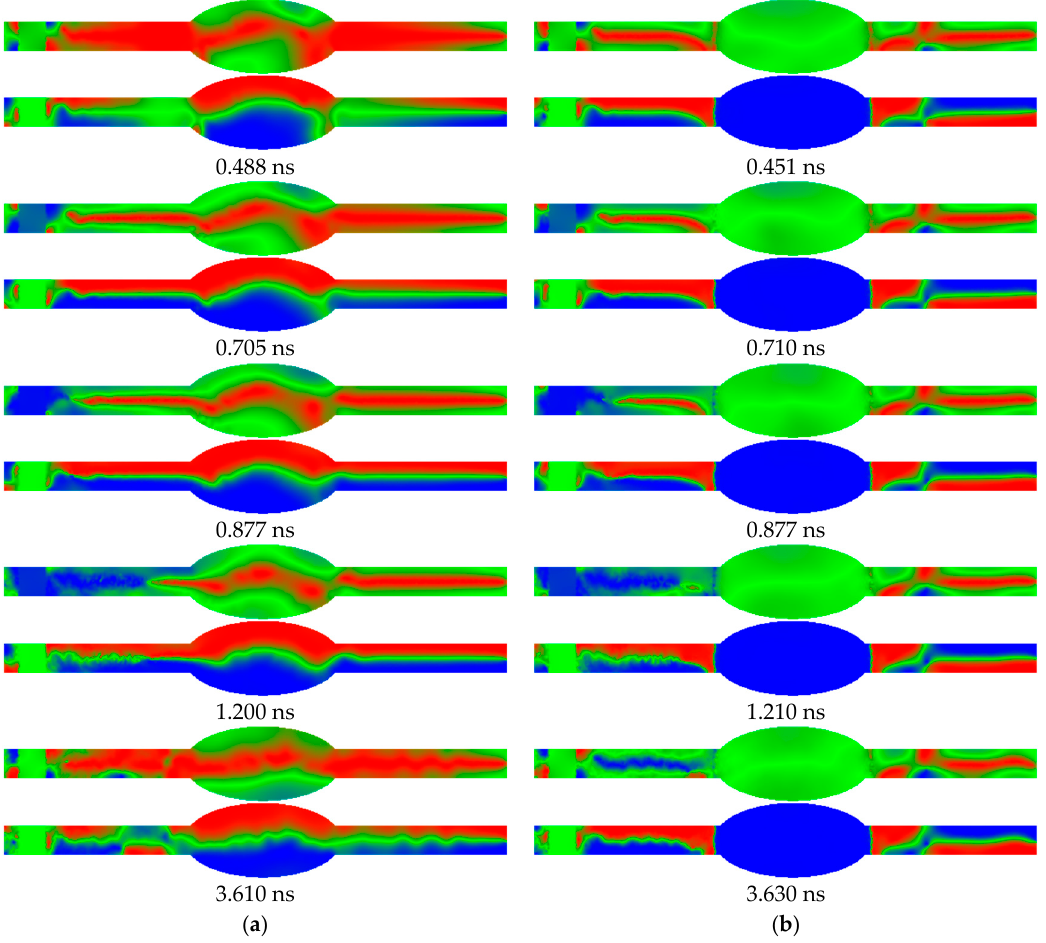
Figure 3. Time ‐ resolved micromagnetic simulation of a bead on a nanofiber: ( a ) Without static magnetic field; ( b ) with static magnetic field of B = 0.1 T along the ‐ z direction applied at the bead. In each pair of images, the upper one represents the x ‐ magnetization component, the lower one the magnetization in z ‐ direction (cf. Figure 2). Color code: red = parallel to the respective axis; blue = antiparallel; green = perpendicular.